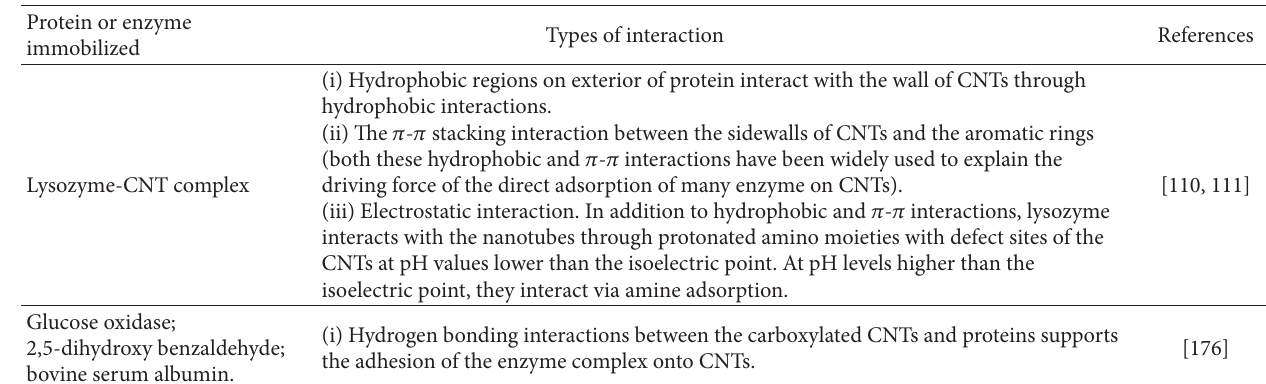
T 5: Noncovalent immobilization by direct physical adsorption.